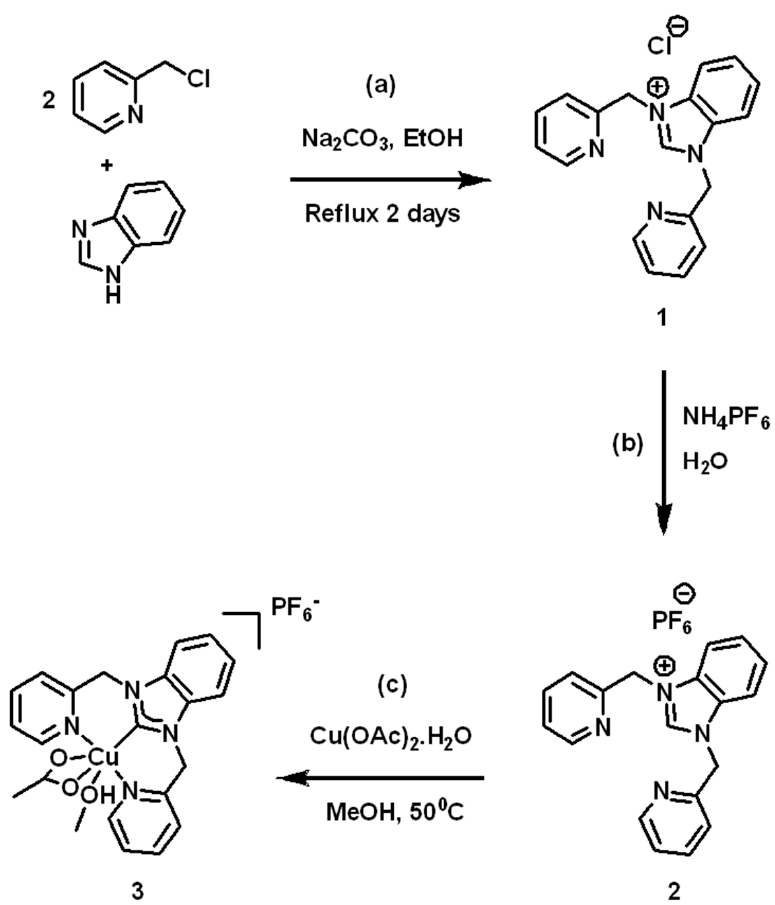
Scheme 1. Reaction scheme for ( a ) ligand generation, ( b ) ion metathesis to PF 6 − salt, and ( c ) carbene generation and metal ion ligation in the formation of the copper(II) NHC complex 3 .